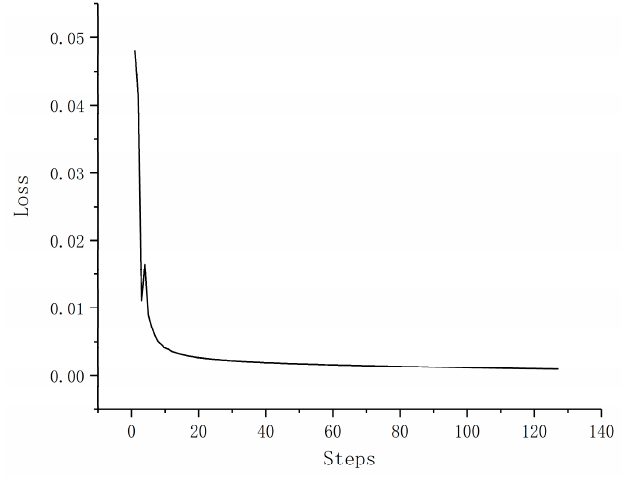
Figure 4. The training error curve of the steam consumption model.